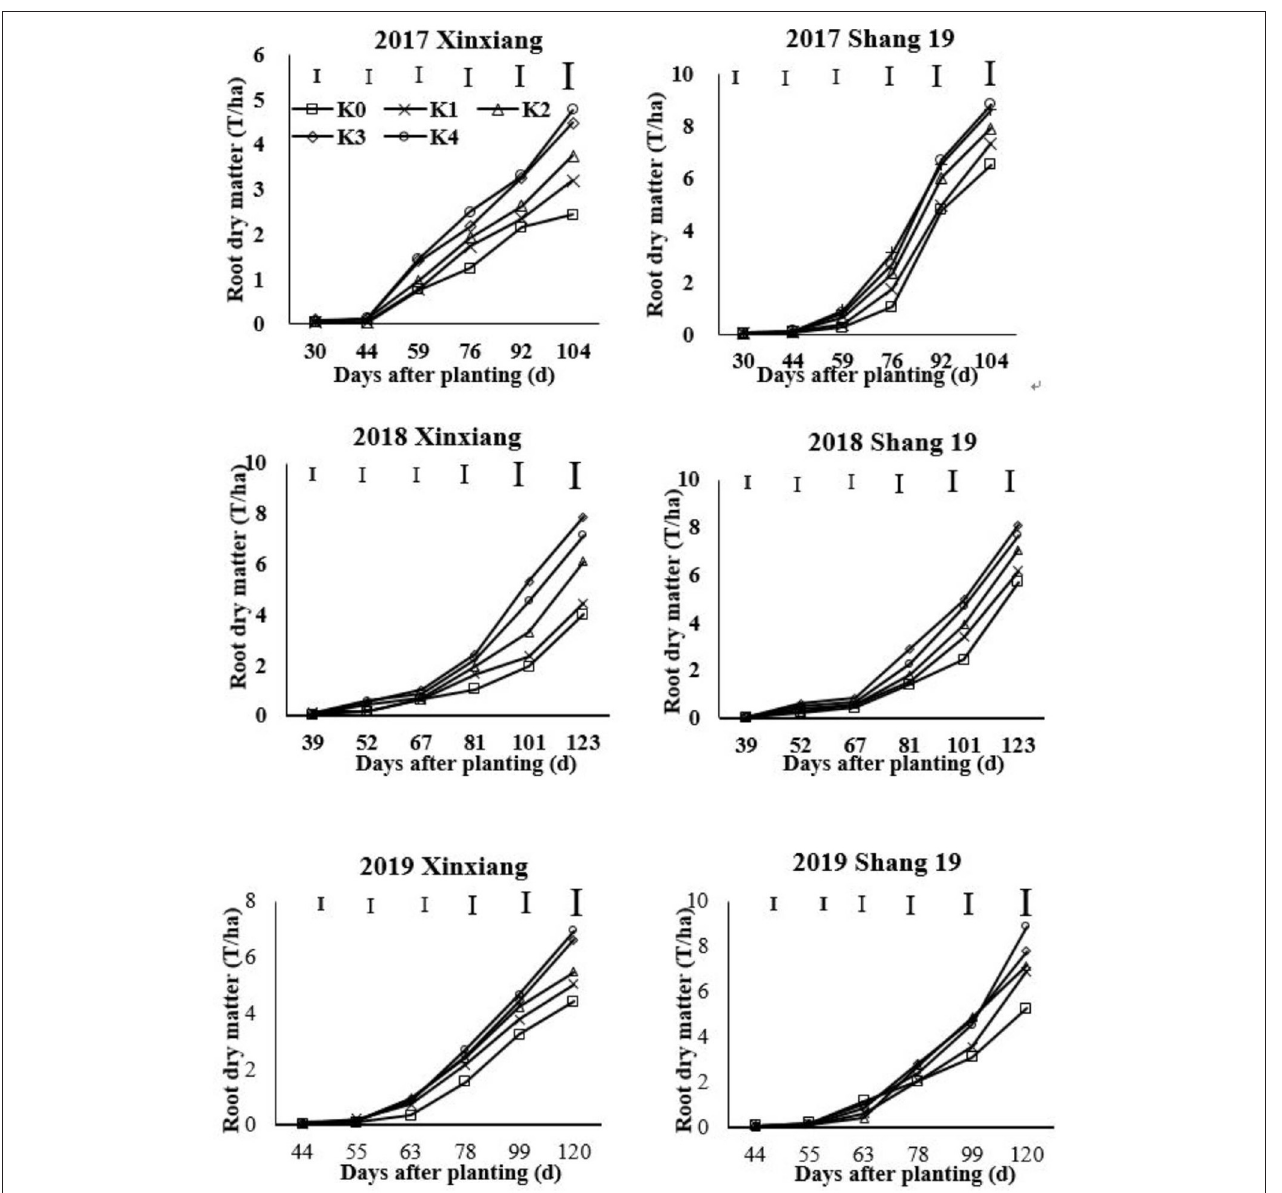
FIGURE 1 | Changes in root dry matter (RDM) for two sweet potato cultivars with time under different potassium (K) fertilization